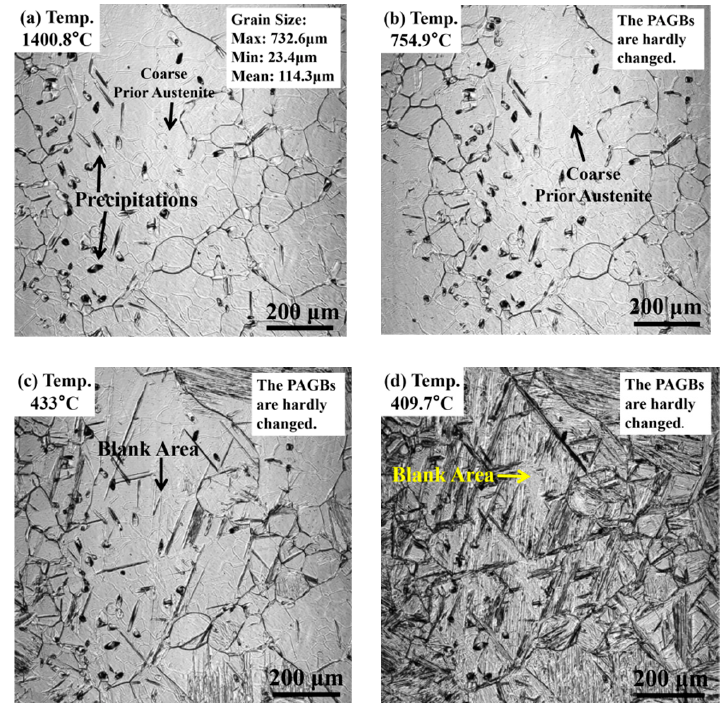
Figure 12. Confocal laser scanning microscopy (CLSM) images of the weld metal for ( a ) initial stage of cooling stage, ( b ) cooling stage at 754 ◦ C, ( c ) cooling stage at 433 ◦ C, ( d ) end stage of cooling